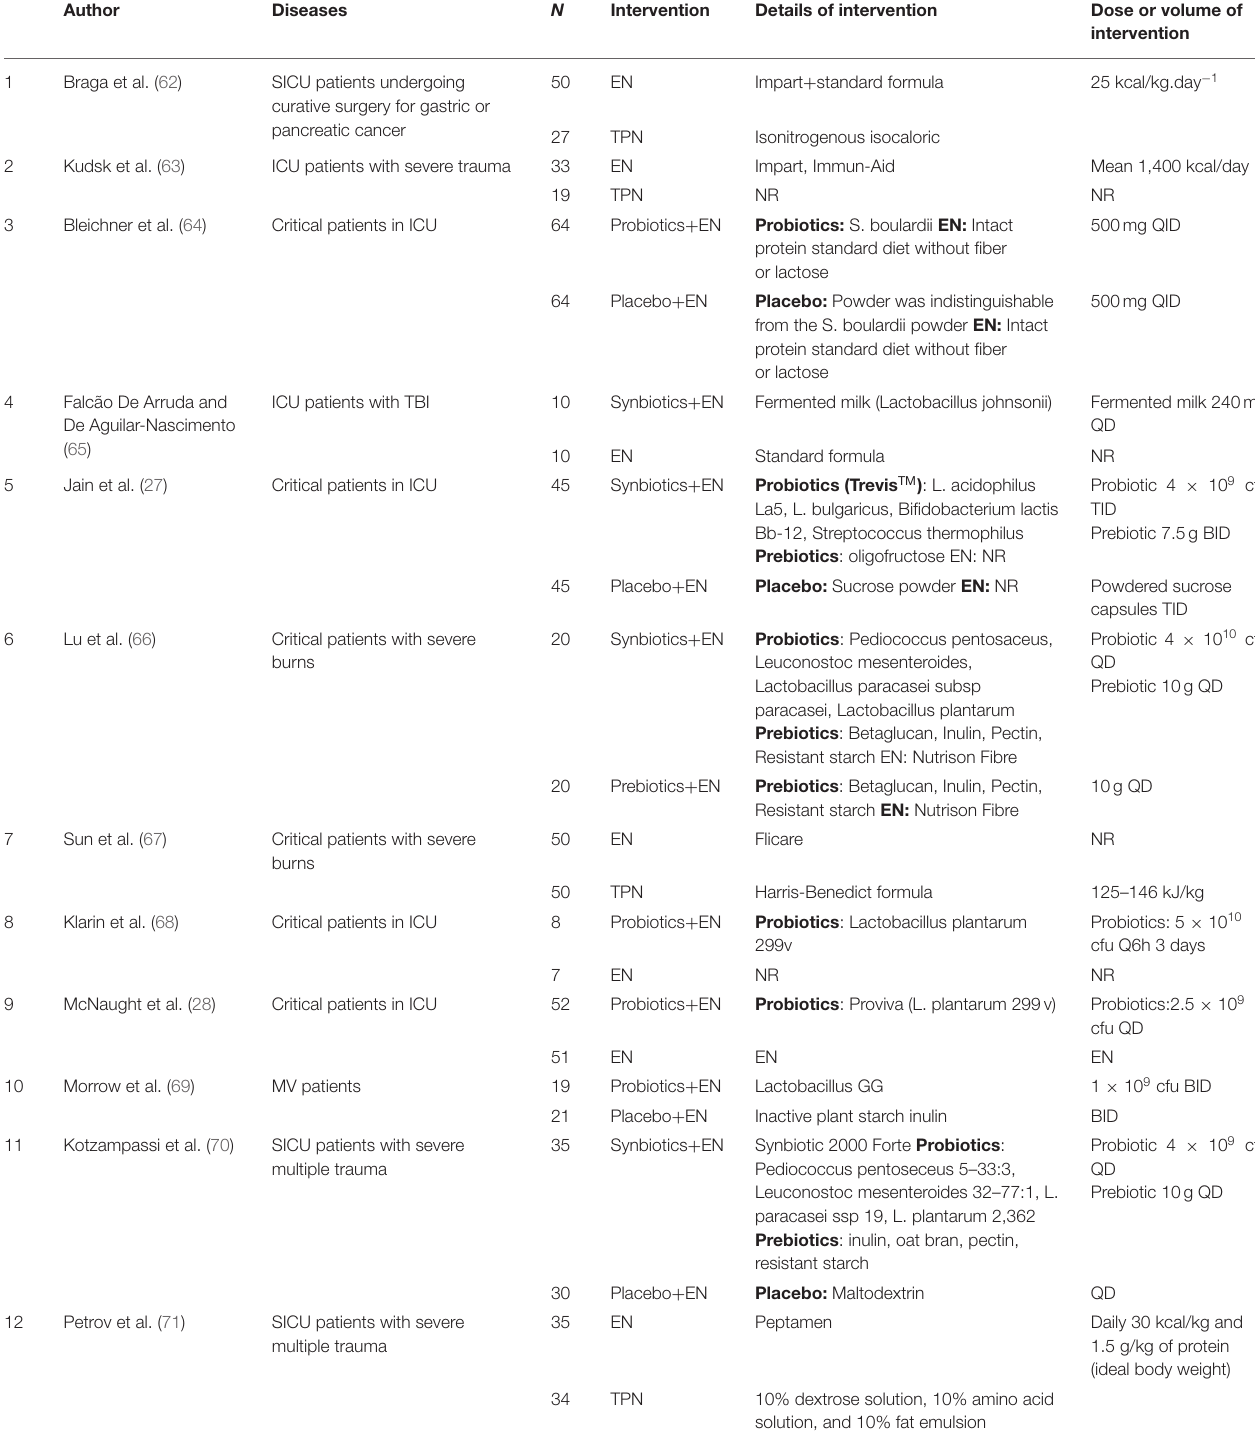
TABLE 2 | Description of included